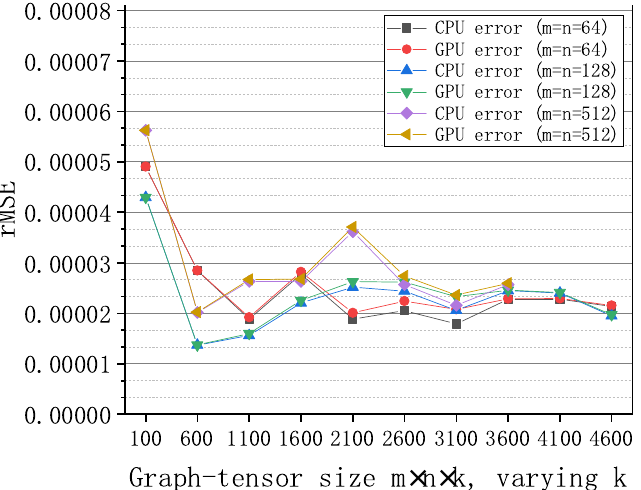
Figure 9. The relative square errors of the algorithm with synthetic graph-tensors of different sizes on GPU and CPU, respectively.